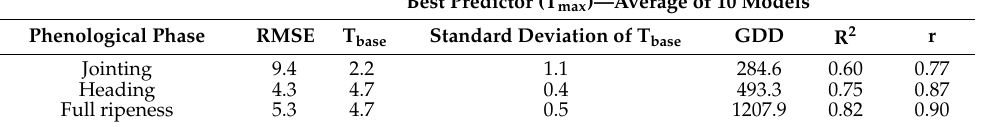
Table 3. RMSE values for given phenophases with the corresponding growing degree day (GDD) and base temperature (T base ) values for the best predictor (T max ) as calibration results of the PhenoClim model. R 2 is the value of the coefficient of determination, and r is the value of the correlation